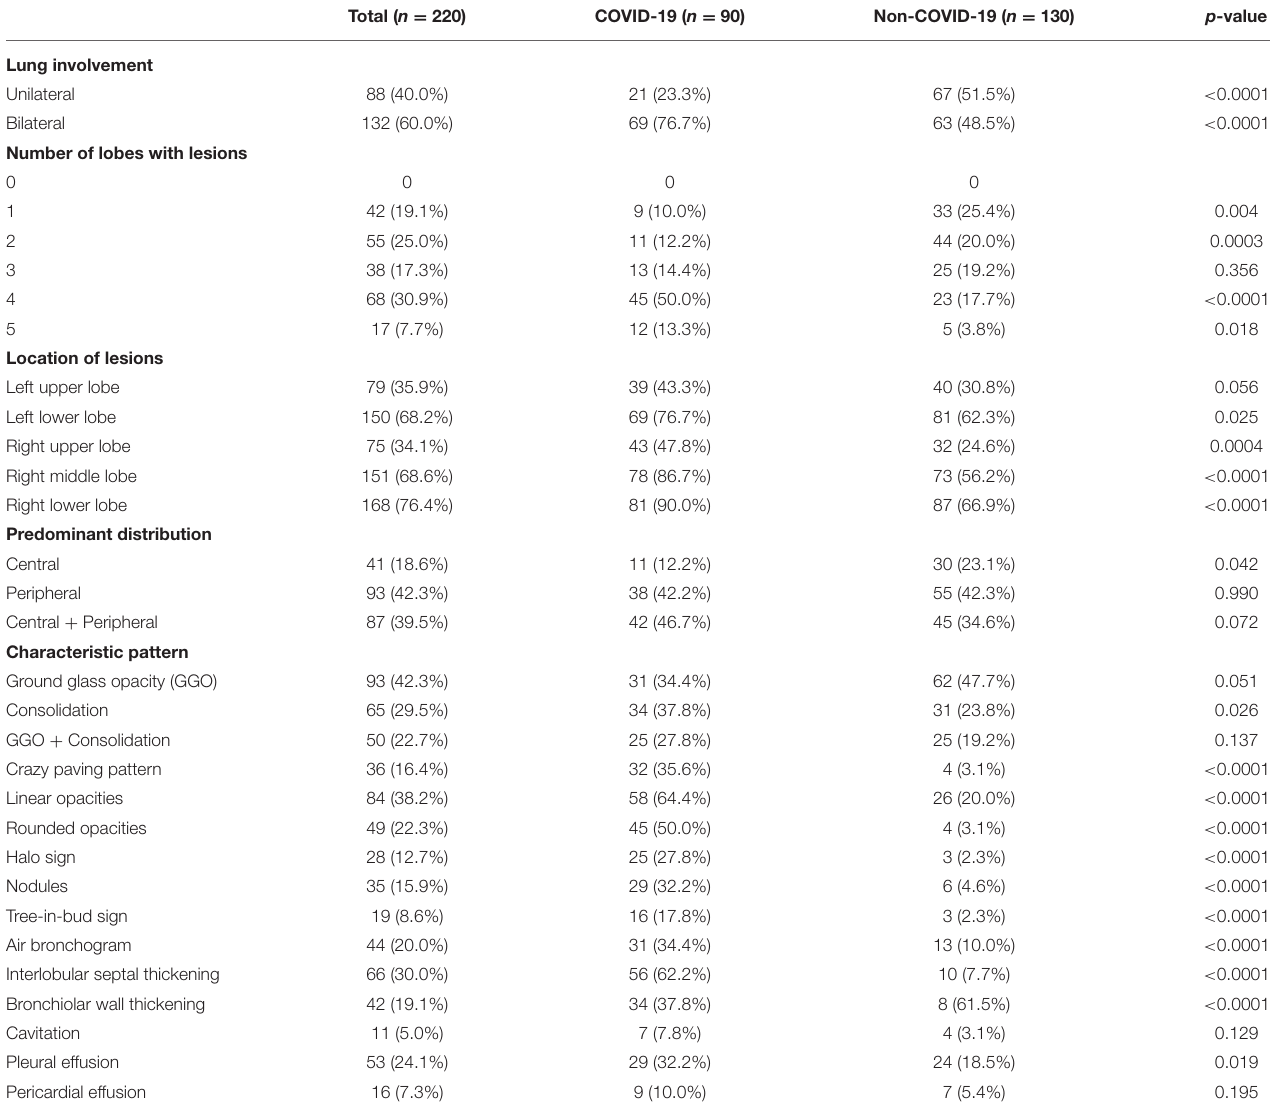
TABLE 4 | Radiological findings of ALI patients in the COVID-19 and non-COVID-19 cohorts. Total ( n = 220) COVID-19 ( n = 90) Non-COVID-19 ( n = 130) p